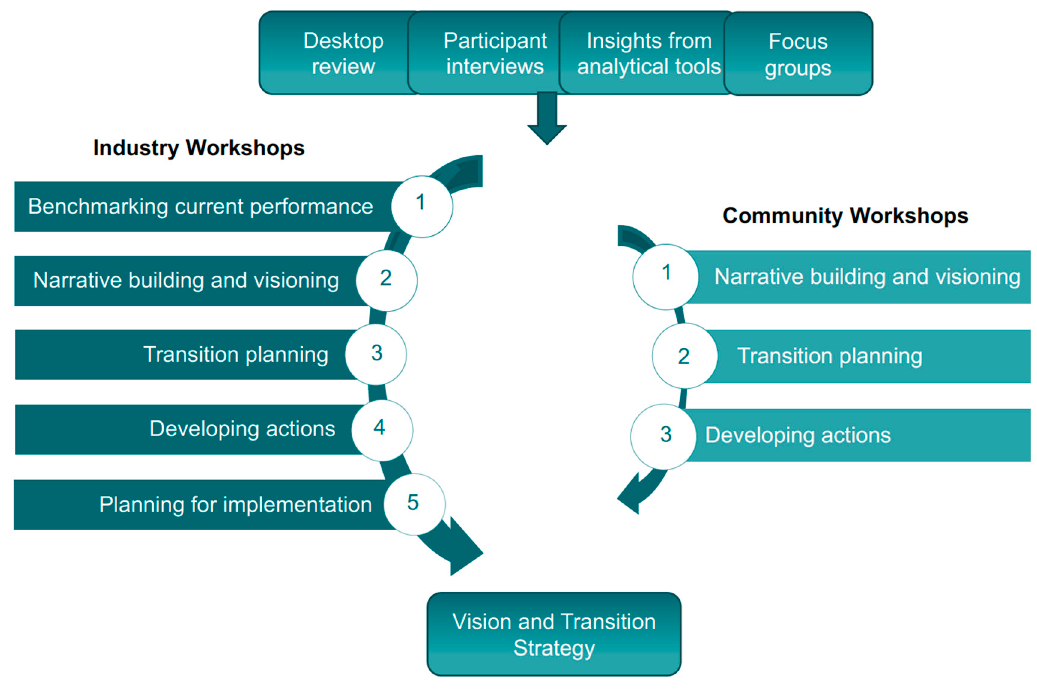
Figure 3. Bendigo methodology [2].